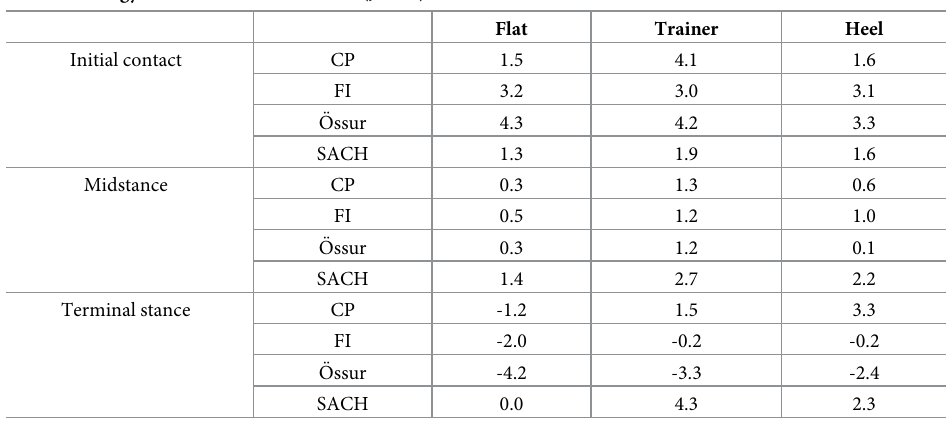
Table 1. Energy stored relative to barefoot (Joules).